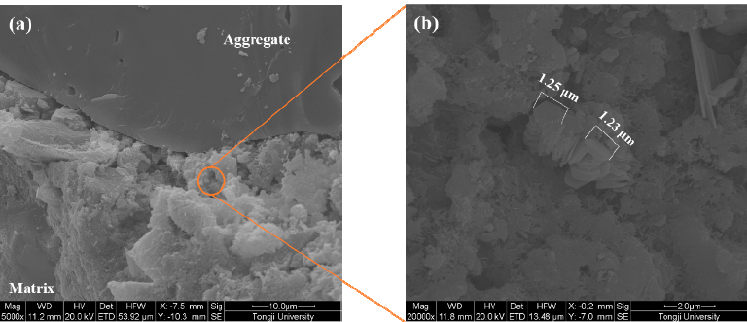
Figure 10. Microstructure of the ITZ of the nano-SiO 2 coated aggregate sample. ( a ) 2000×; ( b ) 20000×.